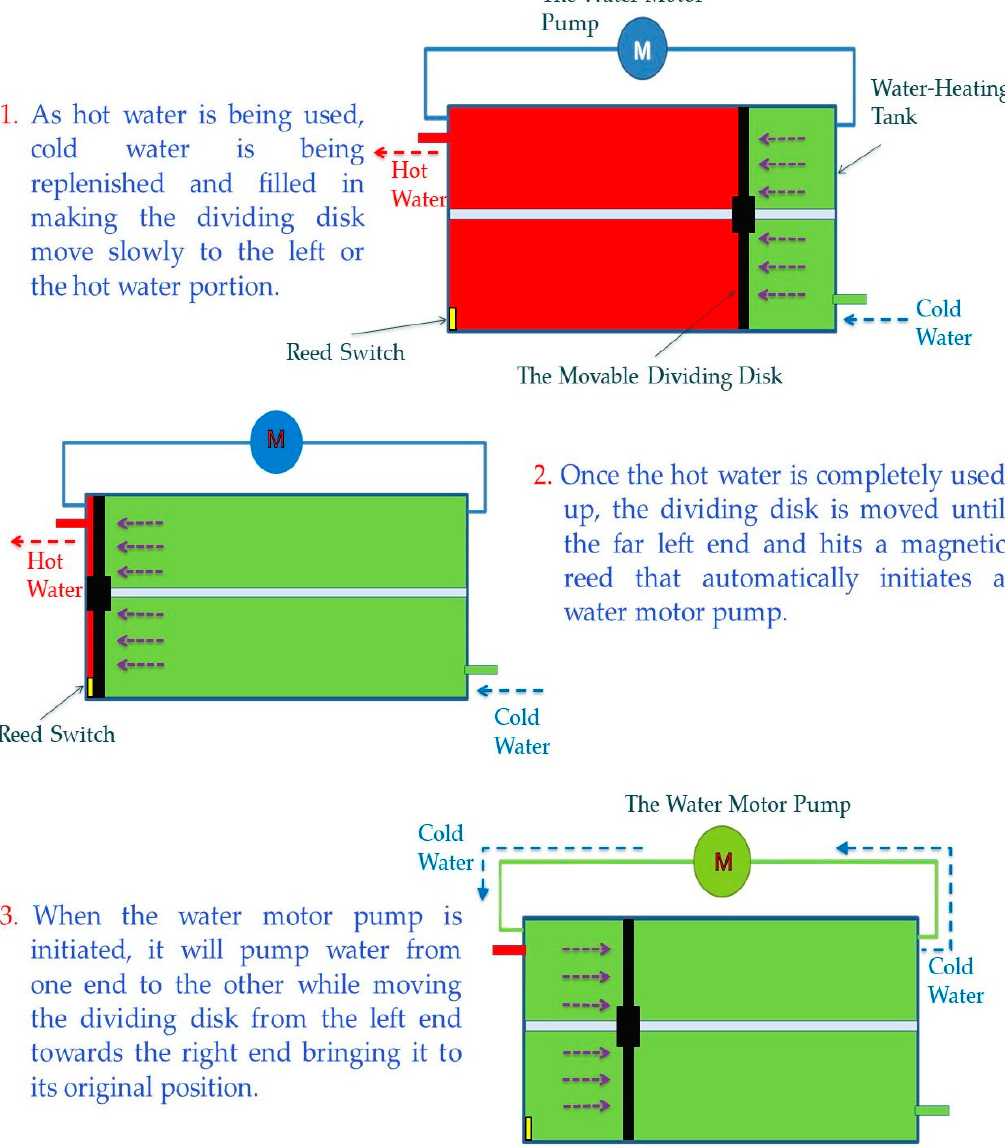
Figure 6. The moving process of the dividing disk of the 3rd generation solar water heating tank.